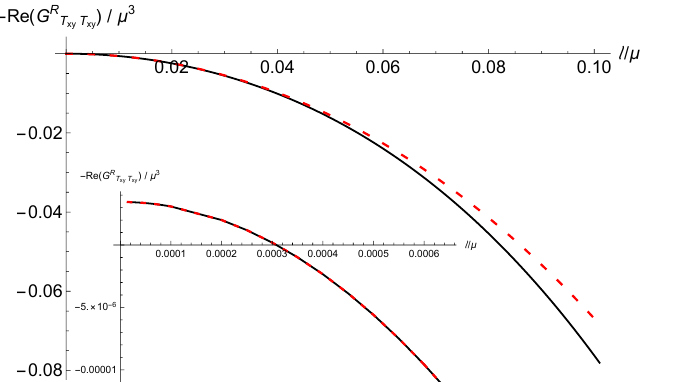
h i G R ( !; q = 0) com- T xy T xy